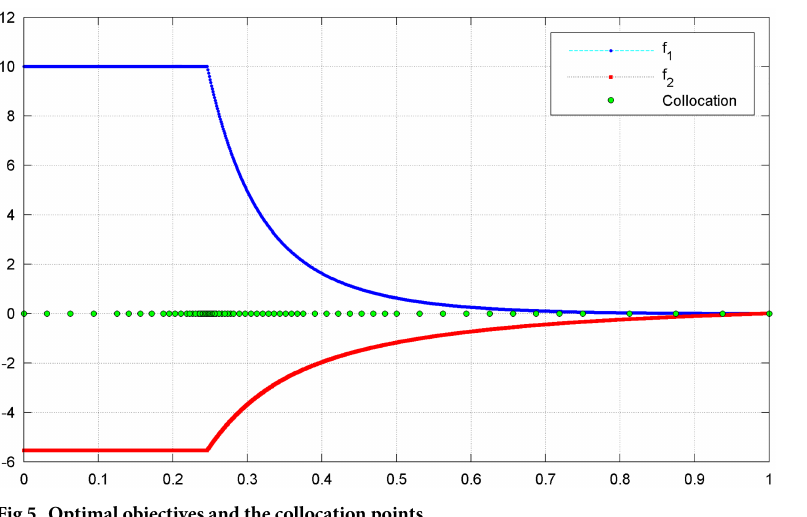
Fig 5. Optimal objectives and the collocation